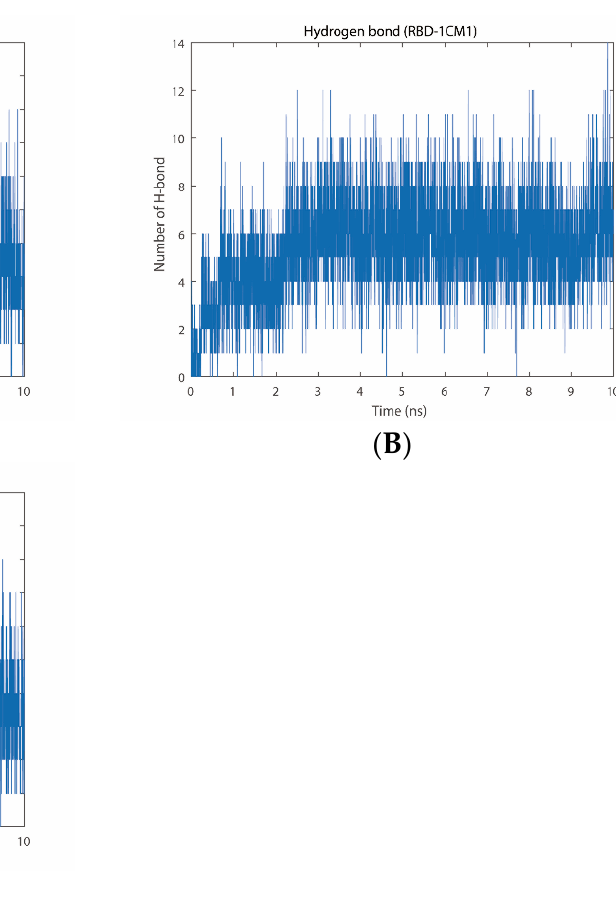
Figure 4. Total energy plots for ( A ) the S protein/RBD-1C complex, ( B ) S protein/RBD-1CM1 com- plex, and ( C ) S protein/RBD-1CM2 complex during the MD simulation.